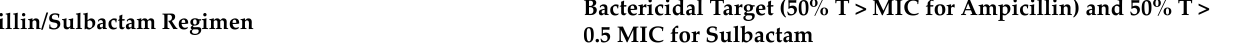
Table 2. Pulmonary PK/PD breakpoints of ampicillin/sulbactam for general treatment with both